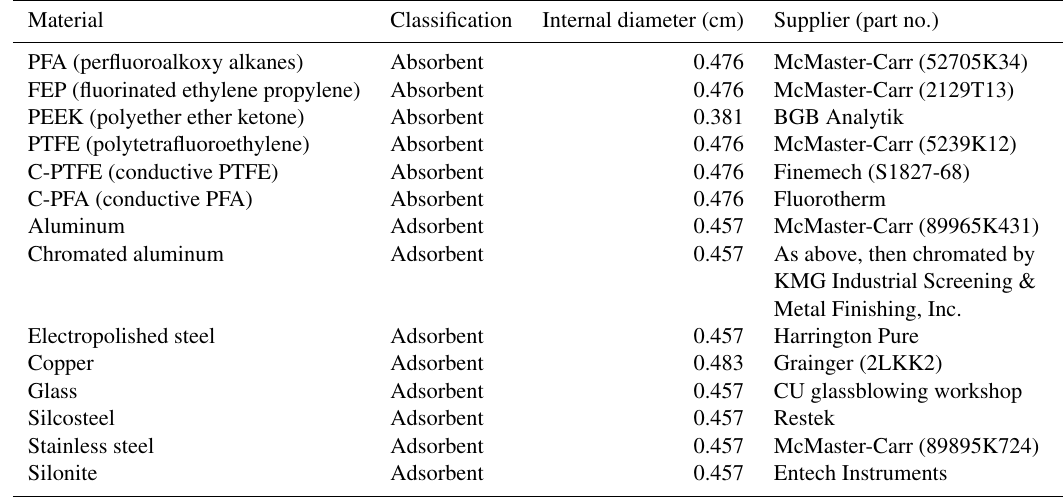
Table 1. Tubing materials investigated in this